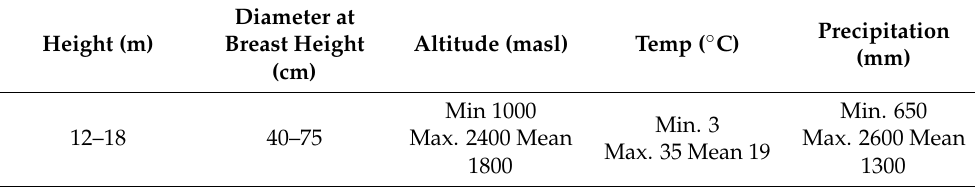
Precipitation (mm)